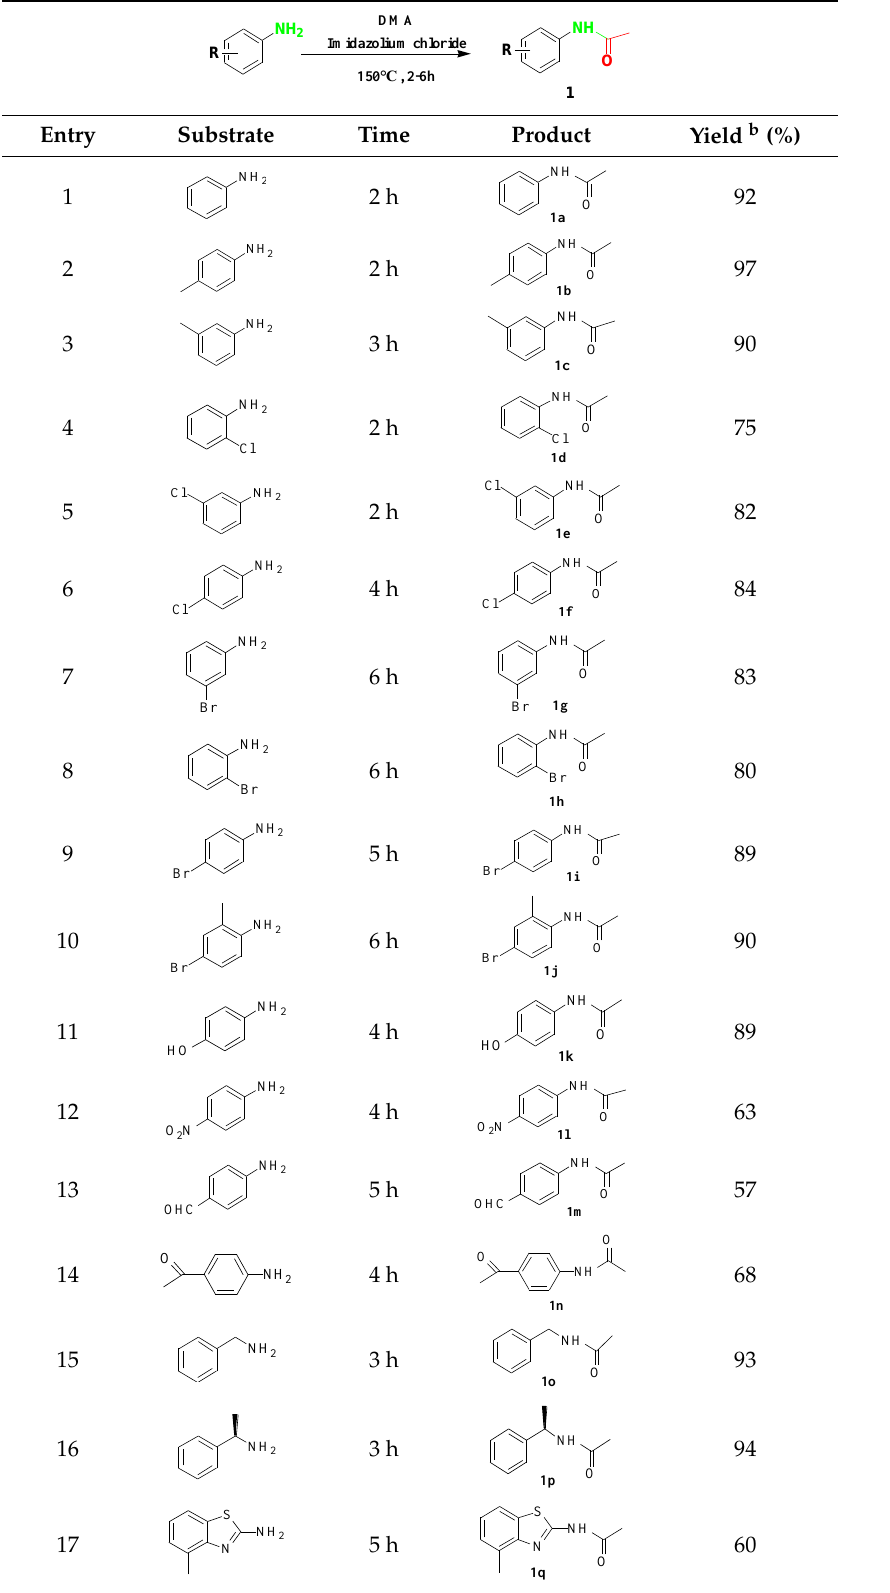
Table 2. Synthesis of benzamides via transamidation a .